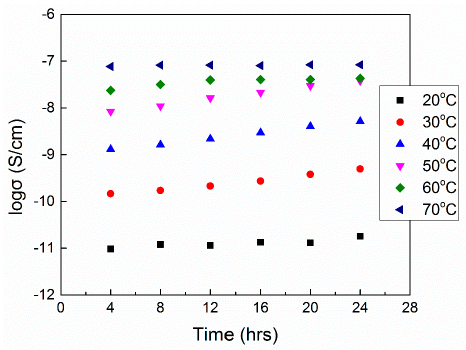
Figure 20. Time dependence of conductivity of the PEO–LiClO 4 (EO:Li + = 8:1)–Al 2 O 3 (20 wt %, 24 nm) system at 20, 30, 40, 50, 60, and 70 °C. Data from Kumar et al. [183]. For longer time scales, the time dependence of conductivity for PEO (600,000 g/mol)–LiClO 4 (EO:Li = 8:1, 10:1)–Al 2 O 3 ( d = 4.8 ± 1.3 nm, concentration = 0, 5, 10, 25 wt %) [185], demonstrated the